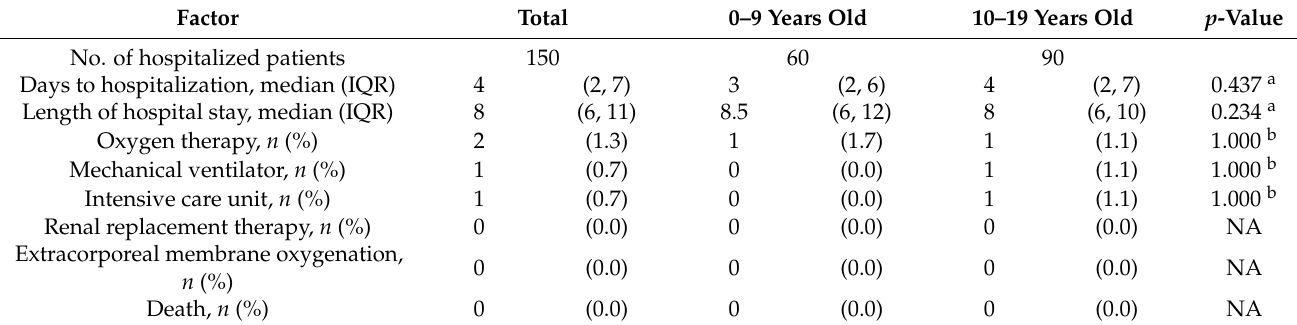
Table 2. Clinical characteristics of hospitalized pediatric patients in Osaka Prefecture,